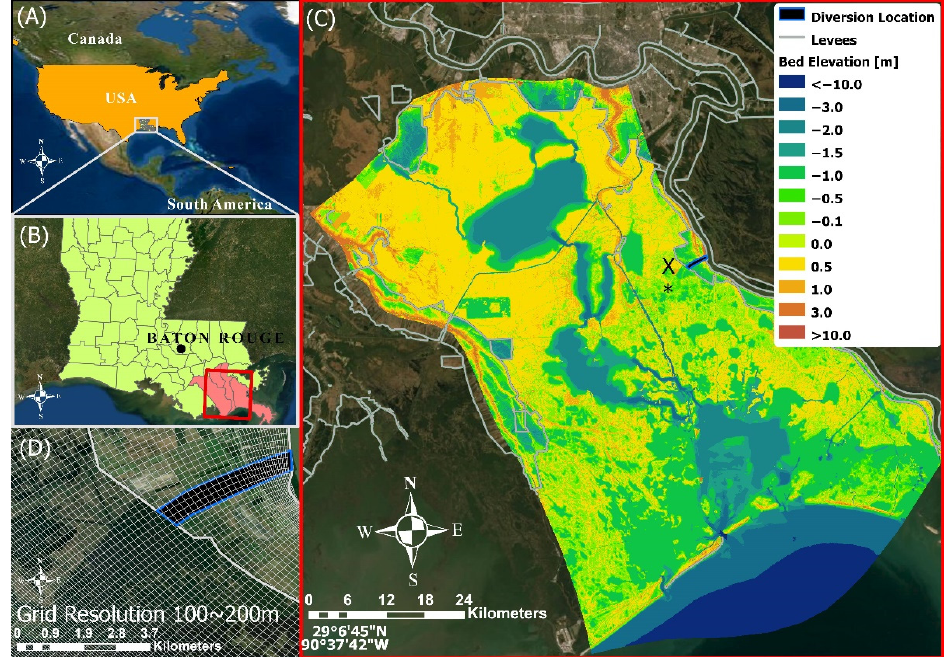
Figure 1. Study site and model domain. ( A ) Location of Louisiana state within the Unites States of America; ( B ) location of Barataria basin within the state of Louisiana; ( C ) digital Elevation Map (DEM) data in (m-vertically referenced to North American Vertical Datum NAVD-88); and ( D ) grid distribution at location (X) in the outfall area of the diversion where grid resolution is 100:200 m.